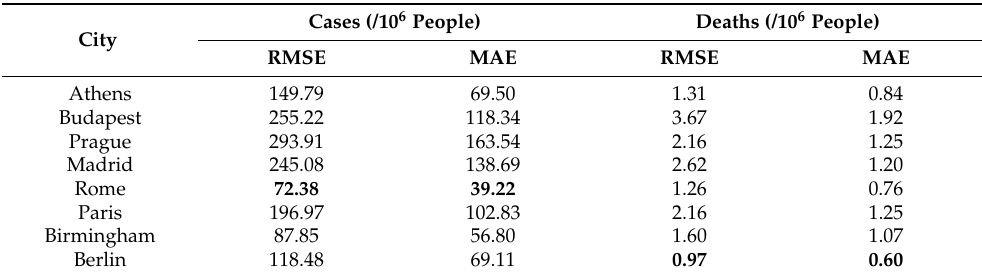
Table 4. The effect of COVID-19 pandemic for different cities. The table shows the performance evaluation of the random forest algorithm for the different cities.